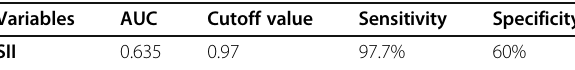
Table 4 AUC, optimal cutoff values, and corresponding performances of SII for differentiation between clear cell RCC and non-clear cell RCC lesions